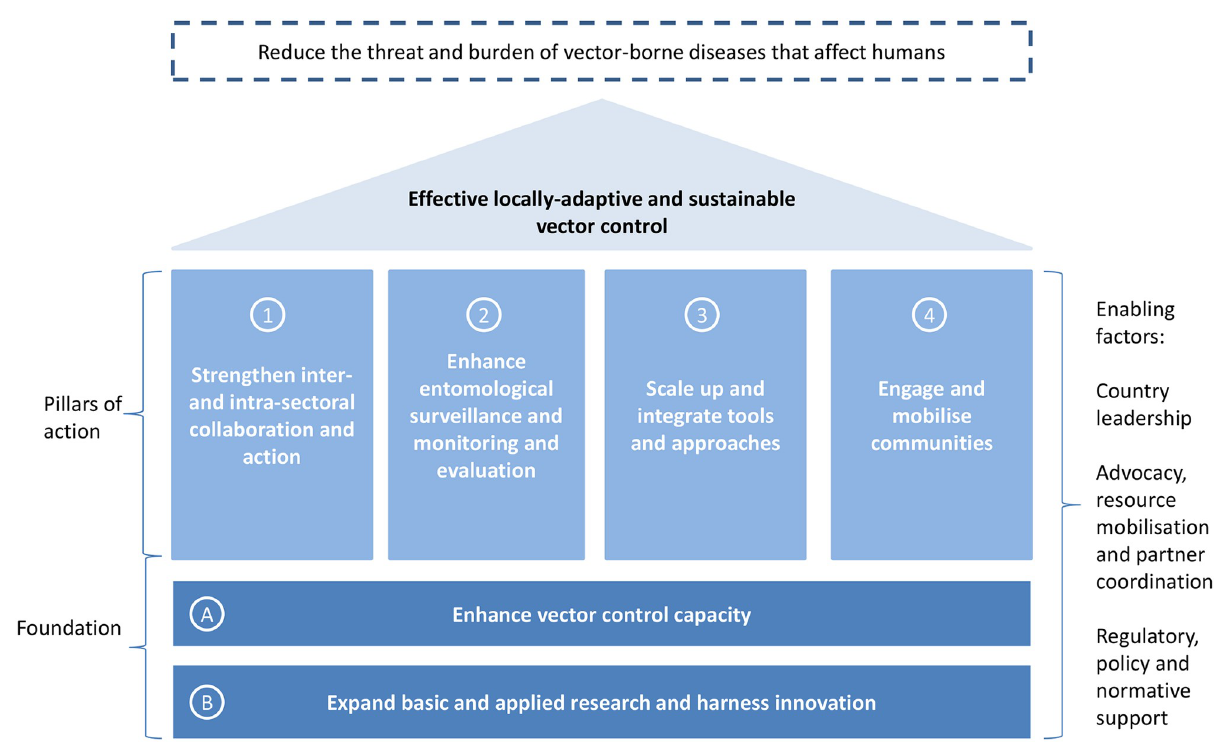
Fig 1. Global Vector Control Response Framework